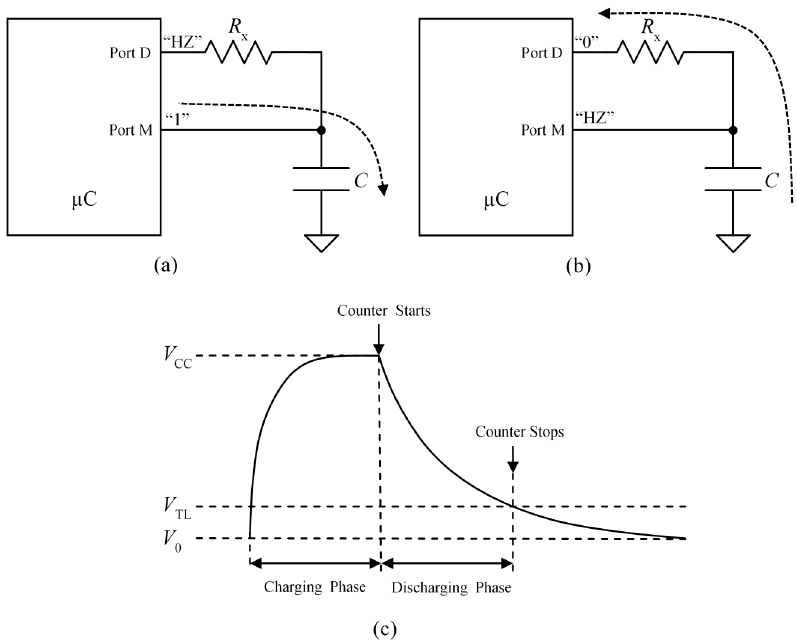
Figure 1. ( a ) Direct interface configured to charge the capacitor; ( b ) direct interface configured to discharge the capacitor and monitor its voltage drop; and ( c ) voltage drop in the capacitor versus time.